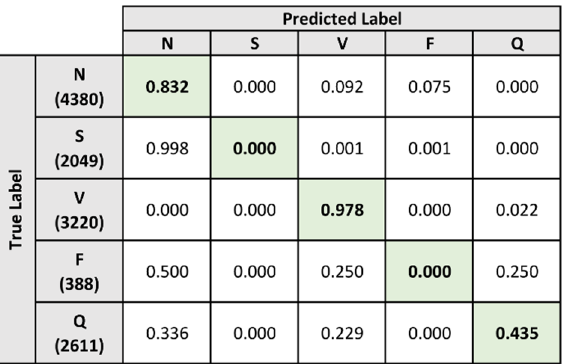
Figure 17. Normalized confusion matrix for composite model on single-lead dataset.